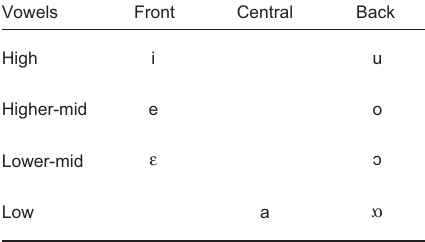
Figure 1. Chart of Assamese Vowel Phonemes